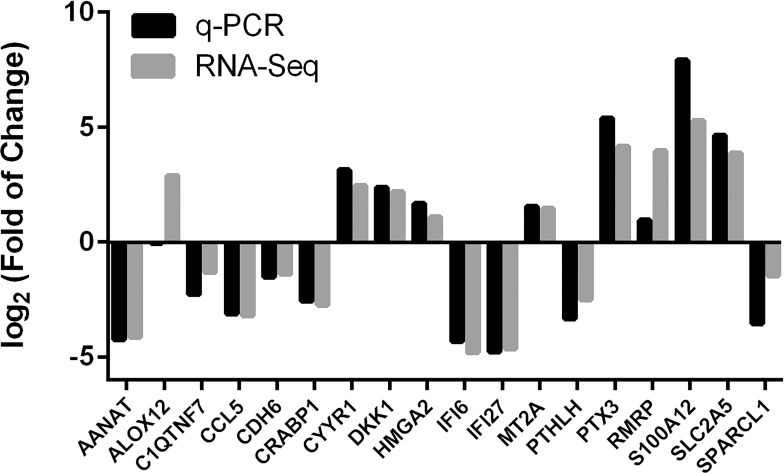
Validation of RNA sequencing findings using qPCR.The same RNA used for RNAseq was used for qPCR. The ΔΔCt method was used for calculation of gene expression changes and actin was used as an internal control. Data analysis/grouping was performed in a similar way as shown in Fig 3. Three of the most up-regulated and down-regulated genes of DEG groups 3, 4, and 5 were studied and compared to RNAseq results. Values of Log2(Fold of change): >0: up-regulation; = 0 non change; <0 down-regulation. n = 3.